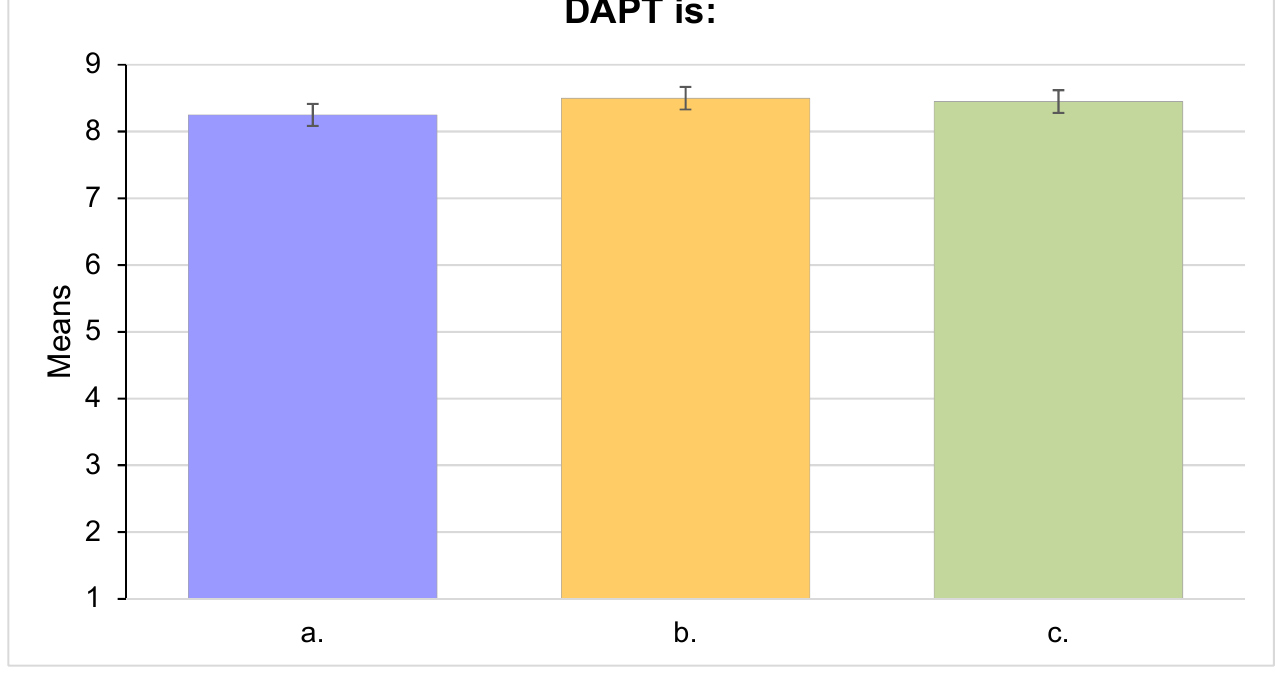
Figure 4. Main barriers to long-DAPT prescription in post-MI CCS patients in clinical practice.